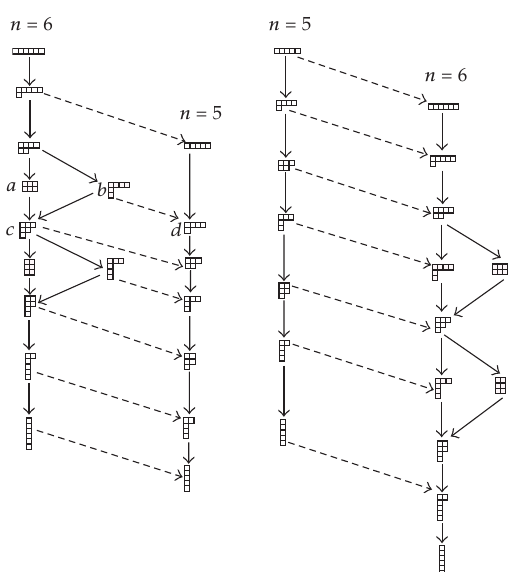
Figure 4: (cid:3) Left (cid:4) Two Ruch lattices to show the order of discrete majorization. The arrows show the direction from the least upper bound to the greatest lower bound and characterize the discrete classical majorization. The dashed arrows between both lattices describe the weak submajorization (cid:5) 17 (cid:6) . The diagrams a and b characterize incomparableness in terms of classical majorization and the diagrams c and d incomparableness of the weak submajorization. (cid:3) Right (cid:4) The same Ruch lattices, but the dashed arrows represent the weak